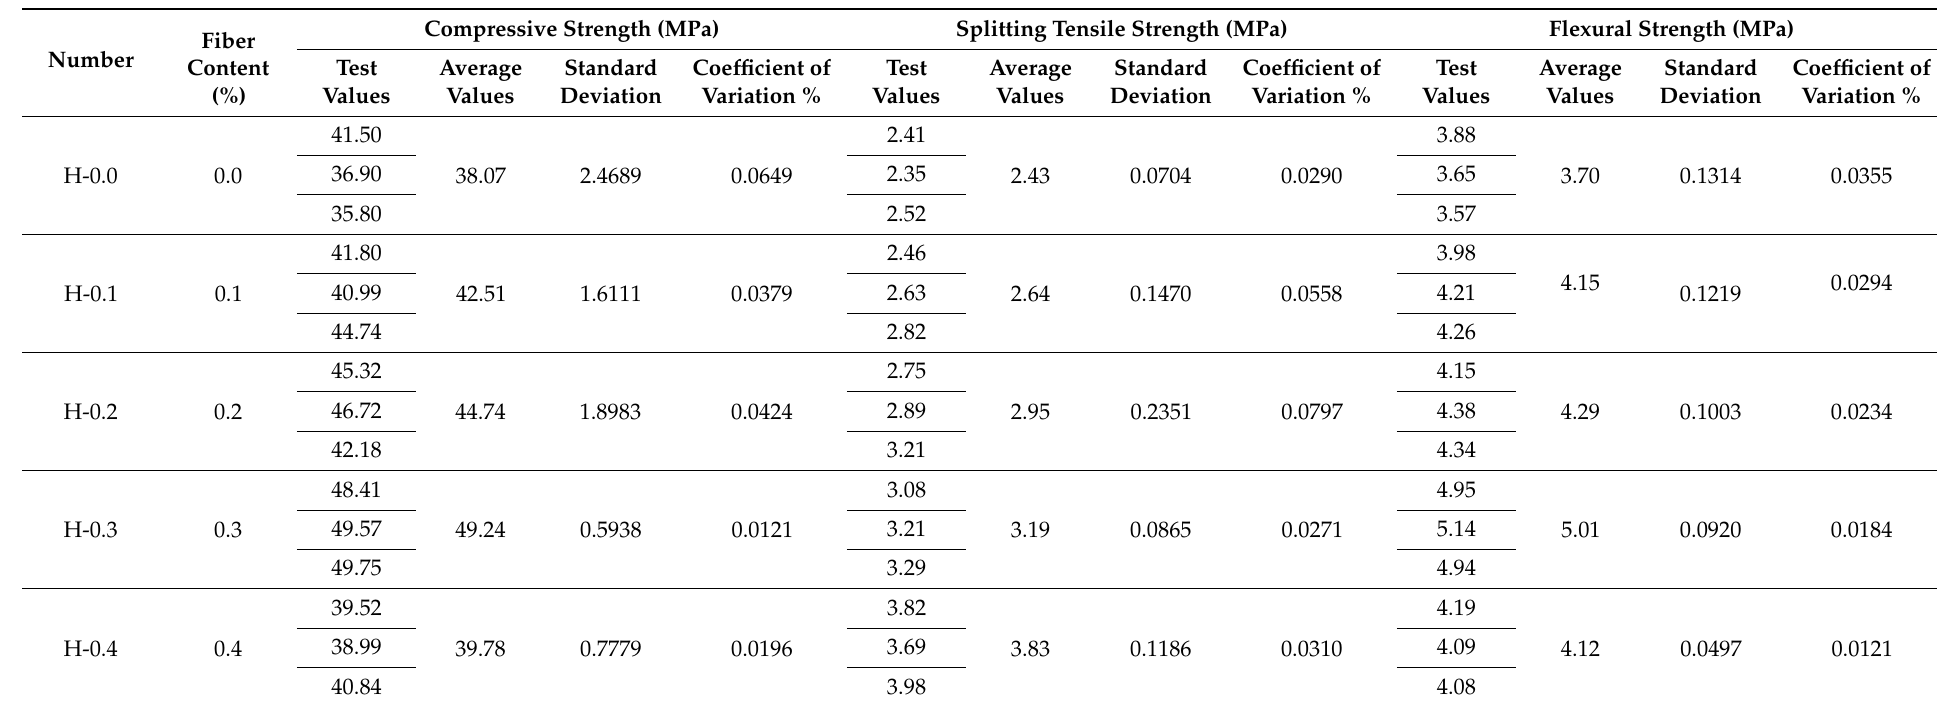
Table 9. Basic mechanical properties of LHPCC with different total hybrid fiber